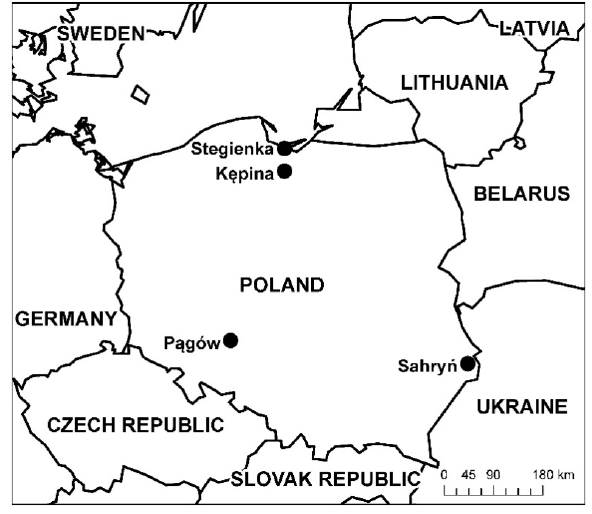
Figure 1. Location of the field experiments.